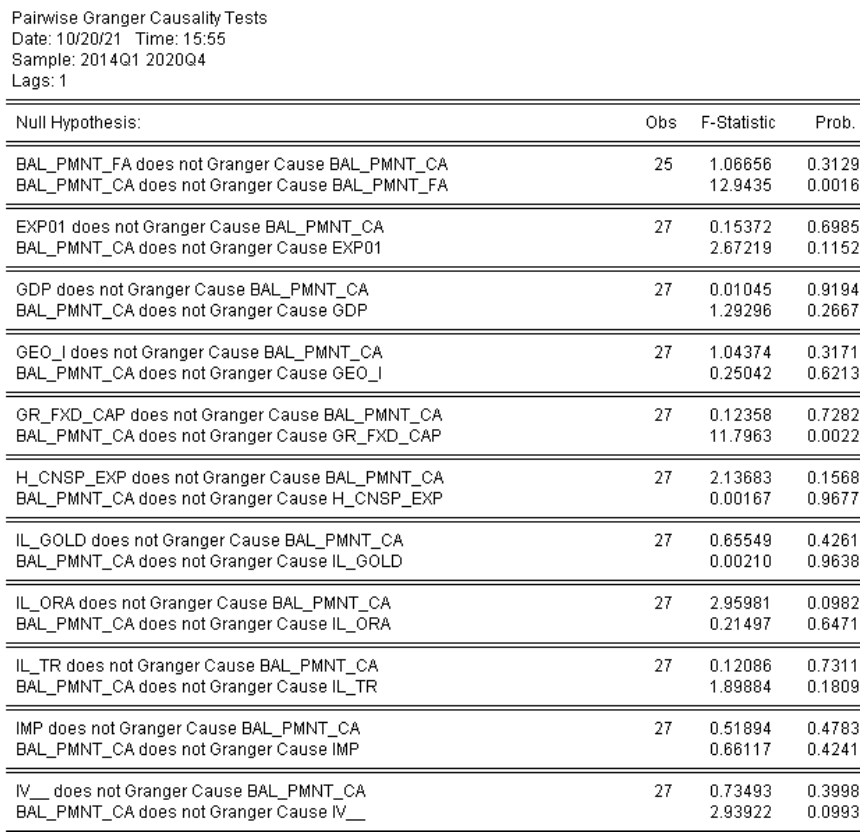
Figure 2. Granger test results Table 2. Statistically significant causal links Null hypothesis Obs.